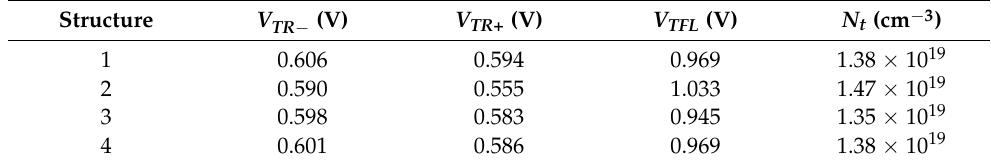
Table 1. Parameters obtained from I-V measurements, based on SCLC theory for different structures. Structure